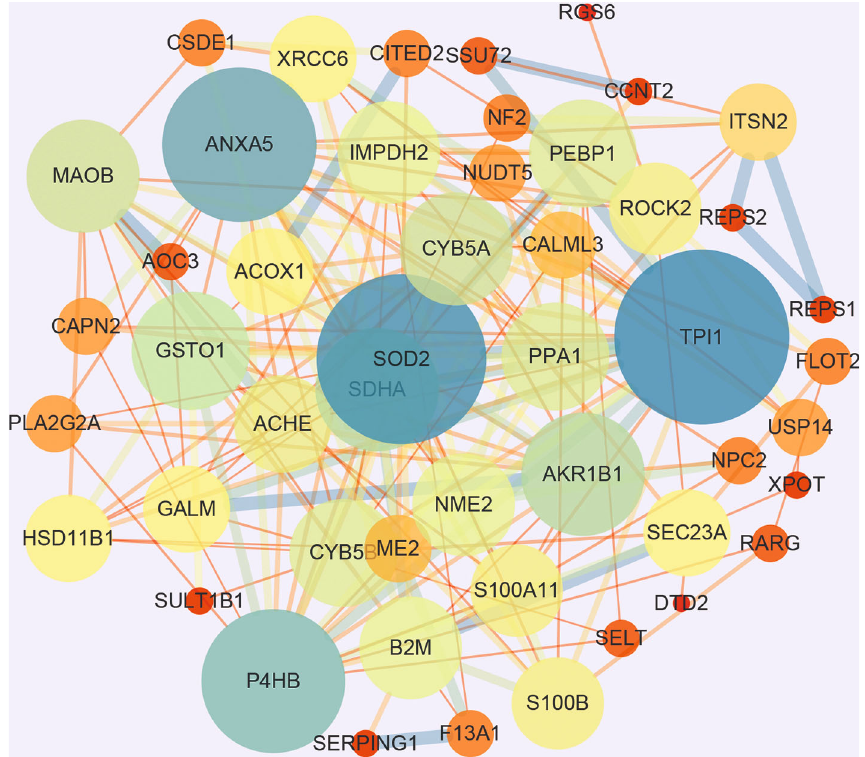
Figure 4: Construction of protein-protein interaction network for common target protein expression of GO and gypenosides. The 46 nodes represent 46 proteins, and the 197 edges represent the interactions between 197 pairs of proteins. The node size and color represent the degree, and the edge size and color represent the comprehensive score.